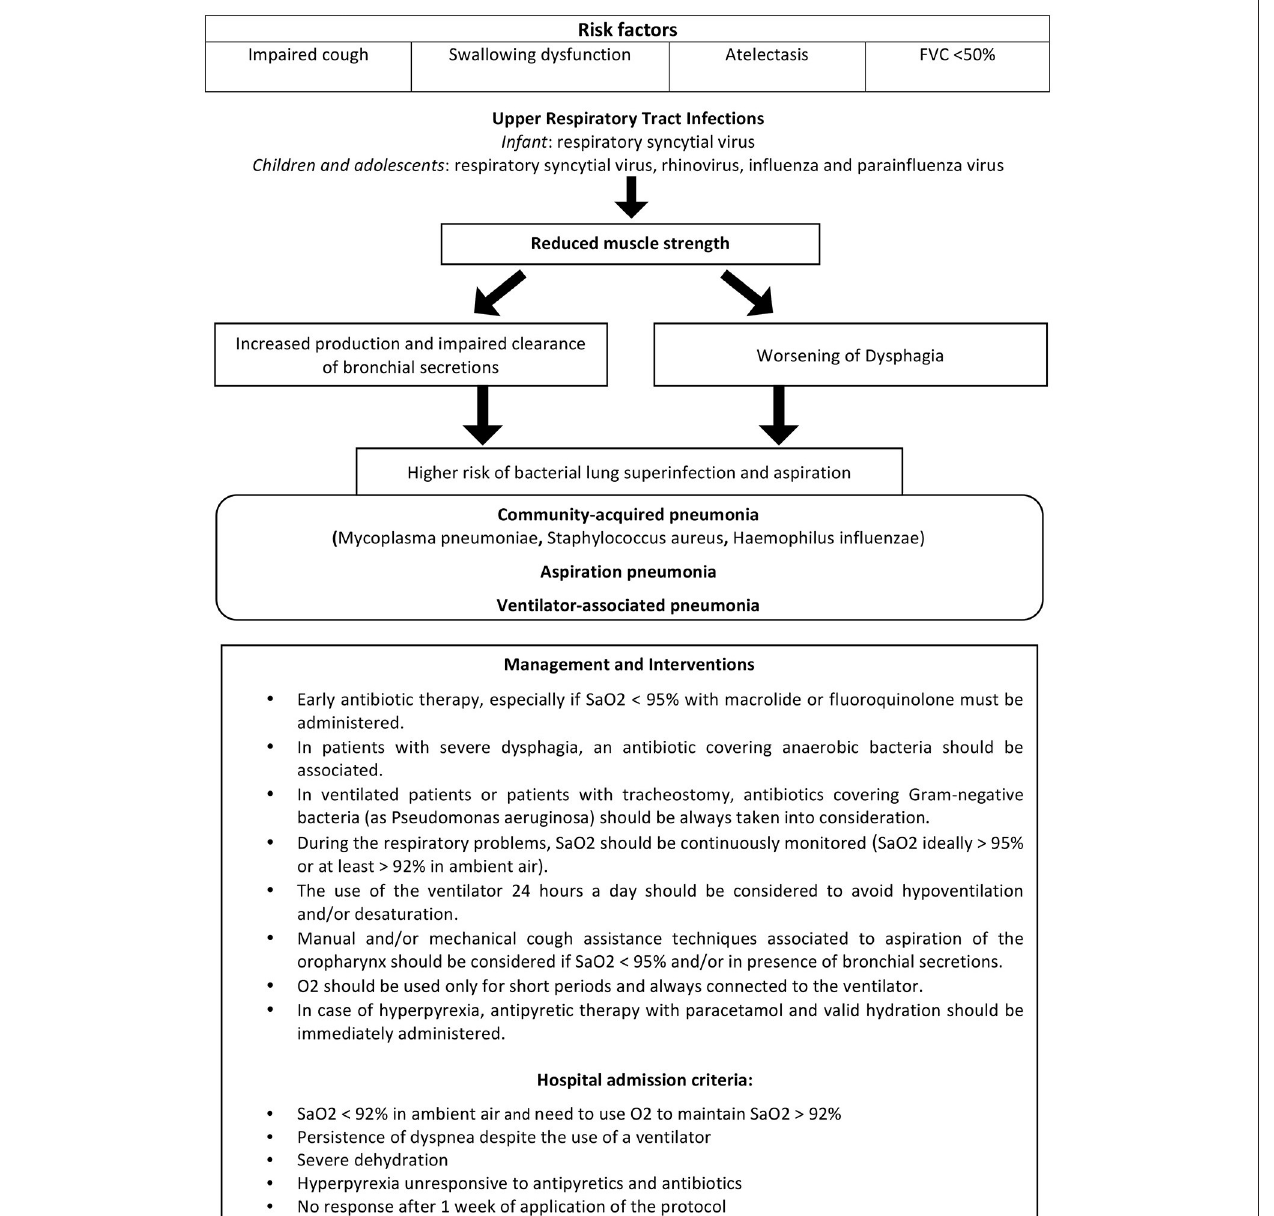
FIGURE 1 | Pathophysiology, clinical management and treatment of respiratory exacerbations/pneumonia in